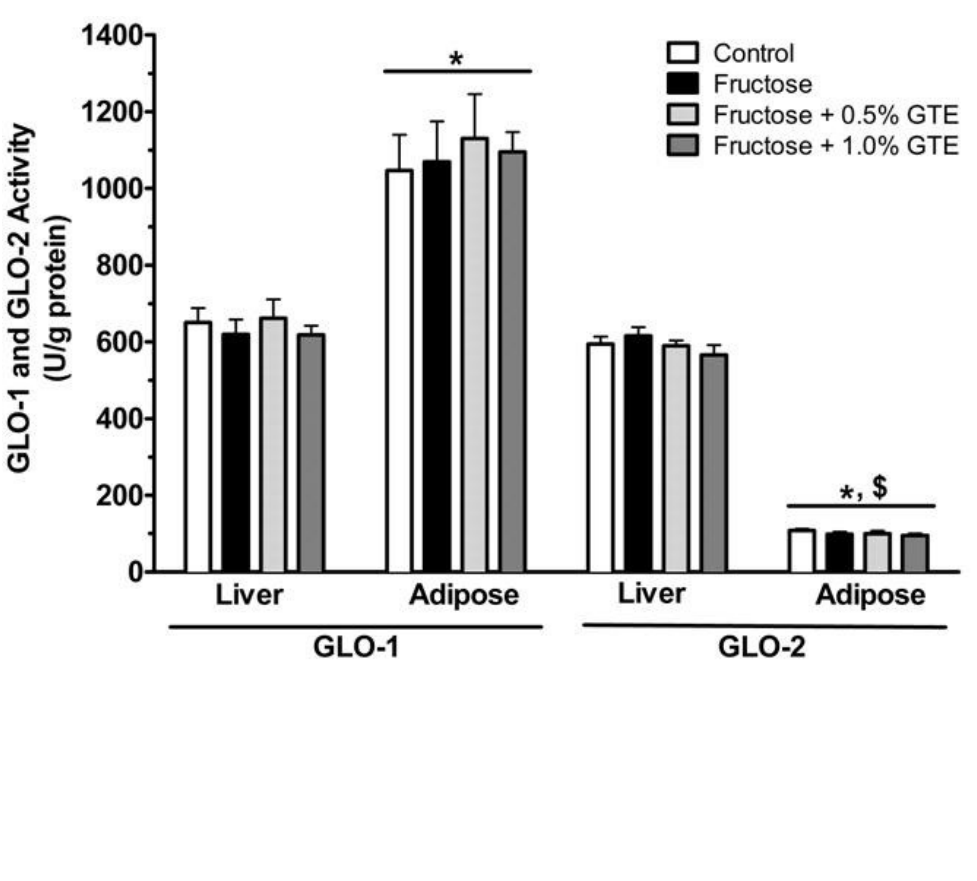
relation was observed between adipose GLO-1 activity and MGO, nor was there any relation between hepatic GLO-1 or GLO-2 activity and hepatic MGO (Figure 5). Figure 3. GLO-1 and GLO-2 activities in liver and adipose tissue. GLO-1 and GLO-2 activities are shown from rats fed a starch-based control diet containing 50% (w/w) starch and 10% (w/w) fructose (Control), a high-fructose diet containing 60% fructose (Fructose), the fructose diet containing 0.5% GTE (w/w) (Fructose + 0.5% GTE), or the fructose diet containing 1.0% GTE (Fructose + 1.0% GTE) for nine weeks (means ± SE; n = 8–9/group). Enzyme activities were measured spectrophotometrically in tissue homogenate. GLO-1 activity was determined by measuring the rate at which MGO-GSH hemithioacetal was converted to S - D -lactoylglutathione whereas GLO-2 activity was determined by measuring the disappearance of S - D / L -lactoylglutathione. Data were analyzed by 3-way ANOVA. Main effect of enzyme was significant ( P < 0.001), but main effects of tissue and group were not ( P > 0.05). A significant tissue by enzyme interaction was observed ( P < 0.001), but no other significant interactions were detected ( P > 0.05). *, significant difference between tissues for the same GLO enzyme ( P < 0.01). $, significant difference between GLO enzymes within a tissue ( P <